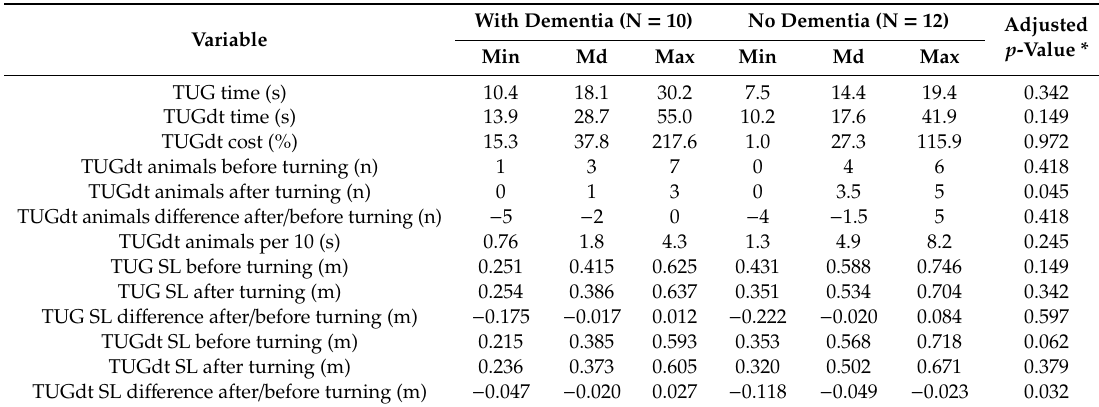
* Comparison between groups using Wilcoxon’s two-sample test and adjusted for age, gender and height with Willett’sresidualmethod;Min = minimum,Md = Median,Max = maximum;TUG = TimedUp-and-Go,TUGdt = TUG dual-task, SL = step